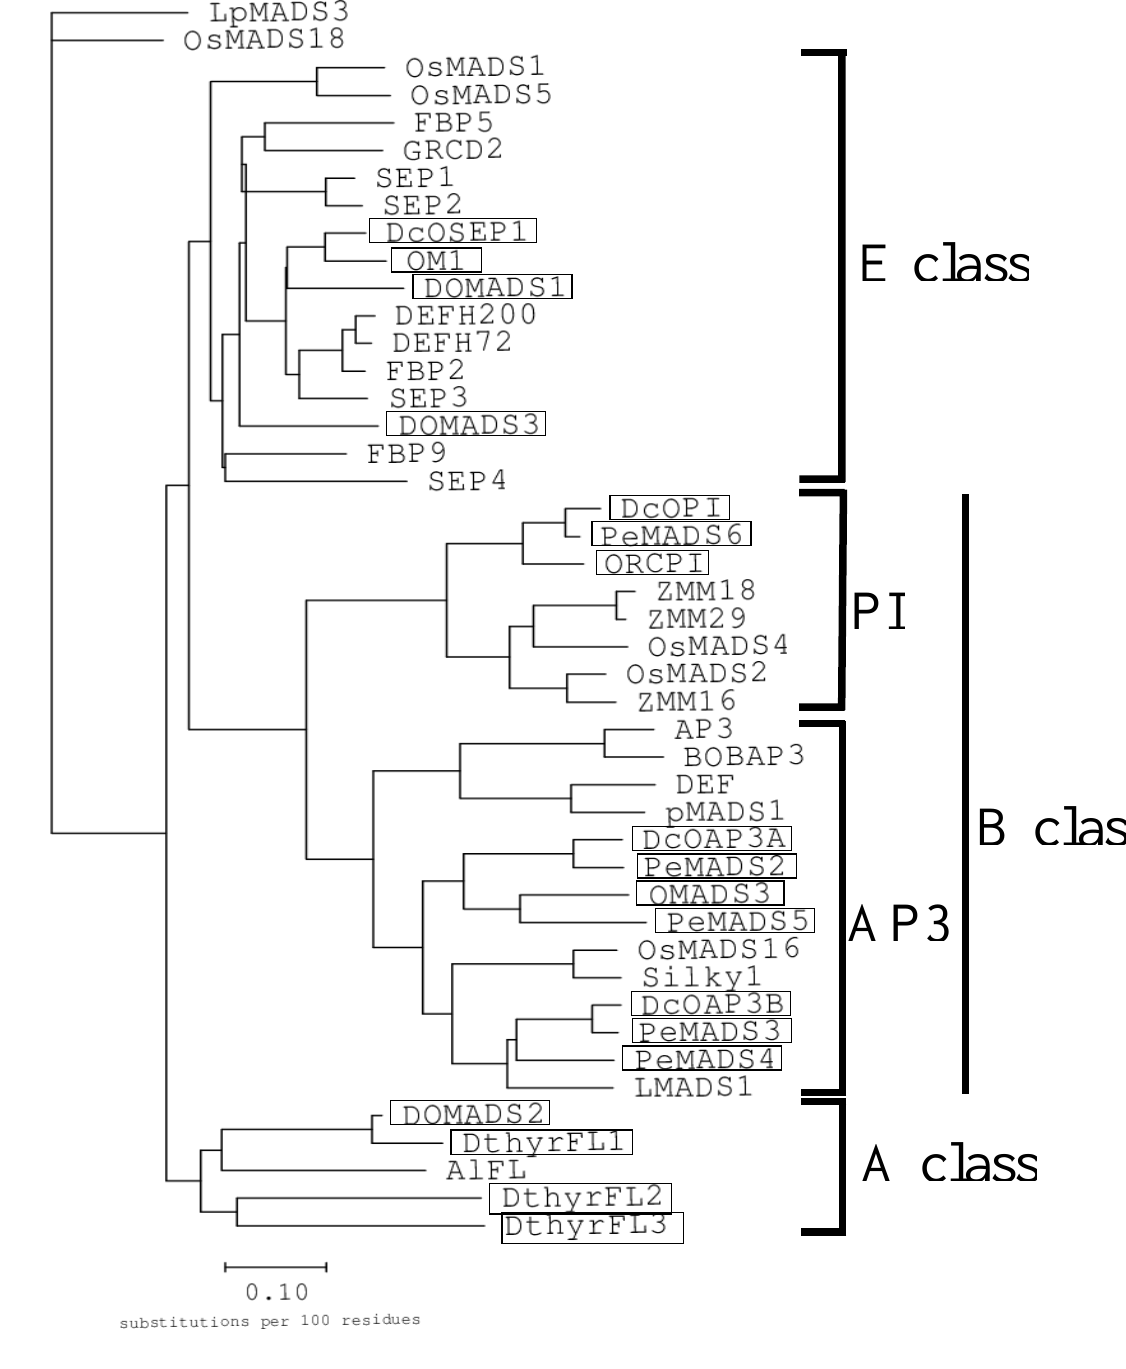
FIGURE 3 . Phylogenetic relationship of MADS-box genes of ABCDE class. (A) Phylogenetic analysis of A-, B-, and E-class genes. (B) Phylogenetic analysis of C- and D-class genes. Orchid MADS-box genes are highlighted by open